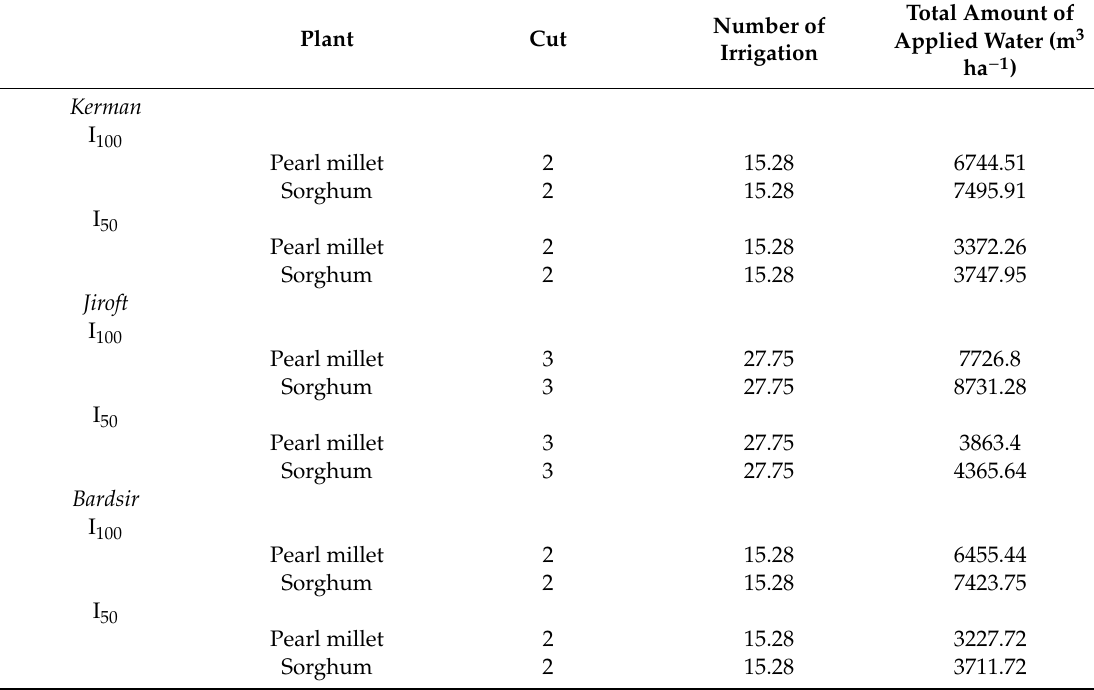
Table 3. The number of cut and irrigation and amount of water consumed per plant and irrigation treatment in Kerman, Jiroft, and